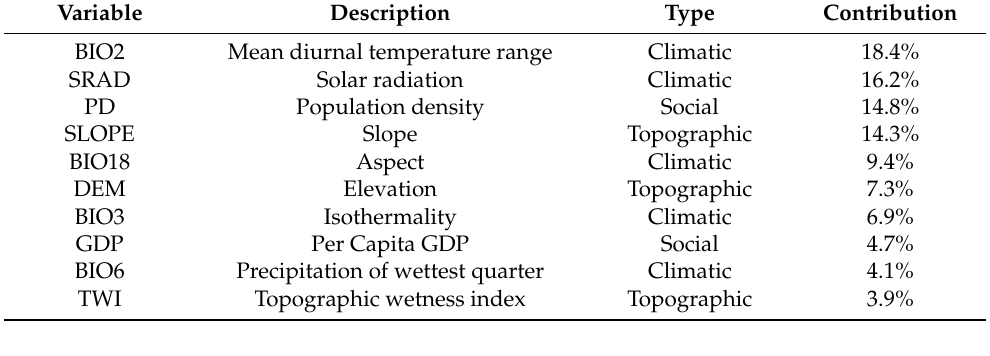
Table 3. Environmental variables adopted in the model.